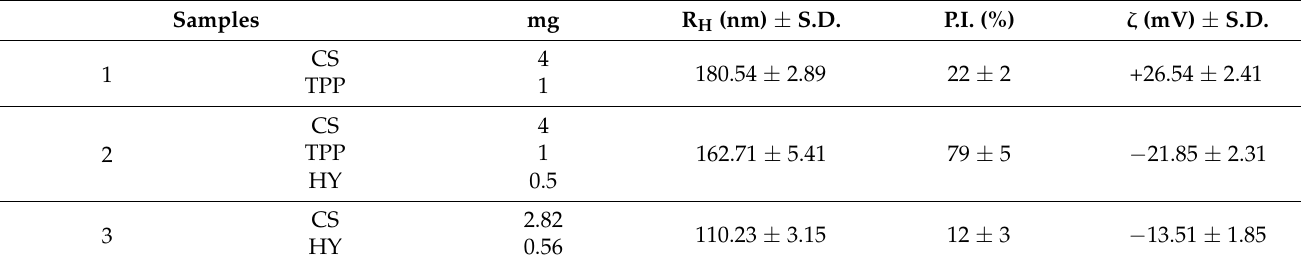
Table 2. Hydrodynamic radius (R H ), polydispersity index (P.I.) and zeta potential ( ζ ) of the